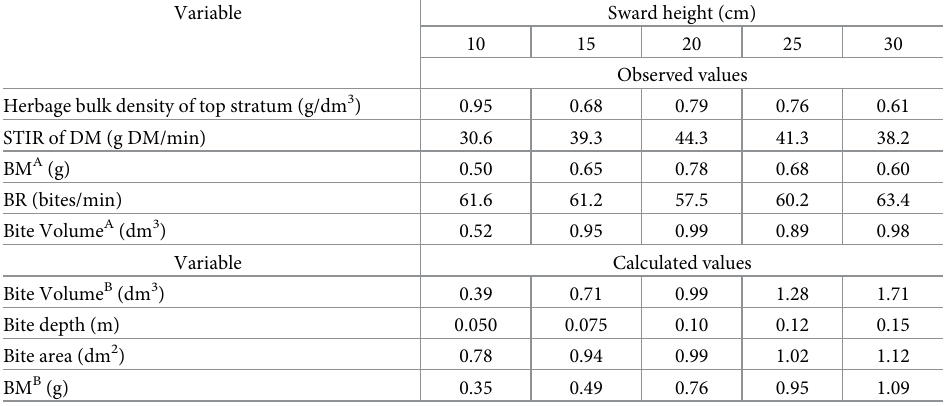
STIR of DM, bite mass (BM A ), and bite rate (BR) are the mean values obtained during the grazing sessions. Bite volume A is the ratio of bite mass to bulk density of top stratum. Bite area was calculated using the equation by [51] bite area = 2 DA 2 (1 + 50/SH) -1 e (-0.3( HBd -1)) , where SH = sward height (cm), HBd = herbage bulk density of the top stratum (g/dm 3 ), and DA = dental arcade (cm). DA was calculated using the allometric equation DA = 8.6 BW 0.36 , published by [52], where BW is body weight (kg). Bite volume B was the product of bite area and bite depth. Bite depth was a constant proportion of 50% of sward height. Bite mass (BM B ) was calculated as the product of bite volume B and bulk density of the top